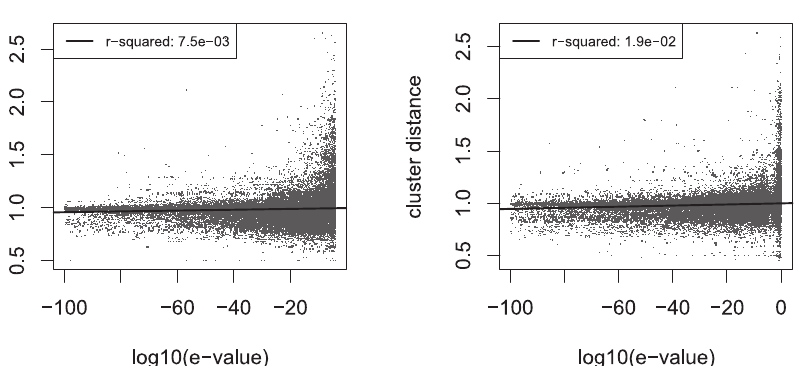
Figure 4. e-Value versus Cluster Distance for SUPERFAMILY (SF) and PSI-BLAST (PB) (A,B) Show there is no correlation between the e-value and cluster distance. The cluster distance indicates whether an occurrence lies within a cluster of occurrences (see Materials and Methods for more details).